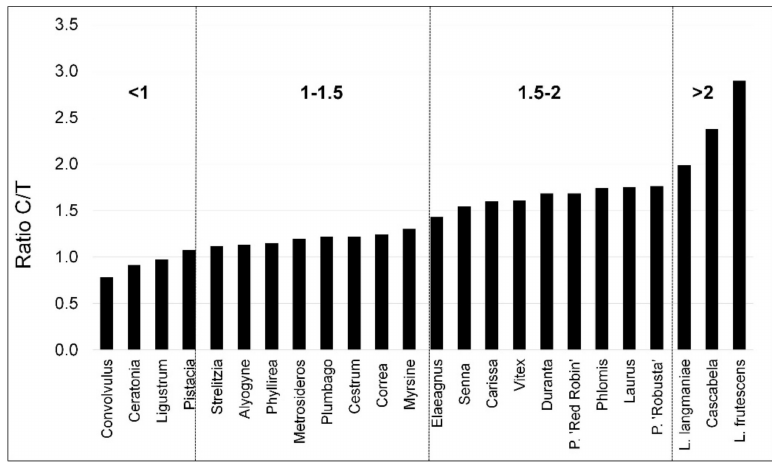
Figure 5. Distribution of the di ff erent studies species in four groups of tolerance, C (Control) and T (salt spray treatment) ratio. Below 1 indicates more tolerant species and above 2 indicates more sensitive